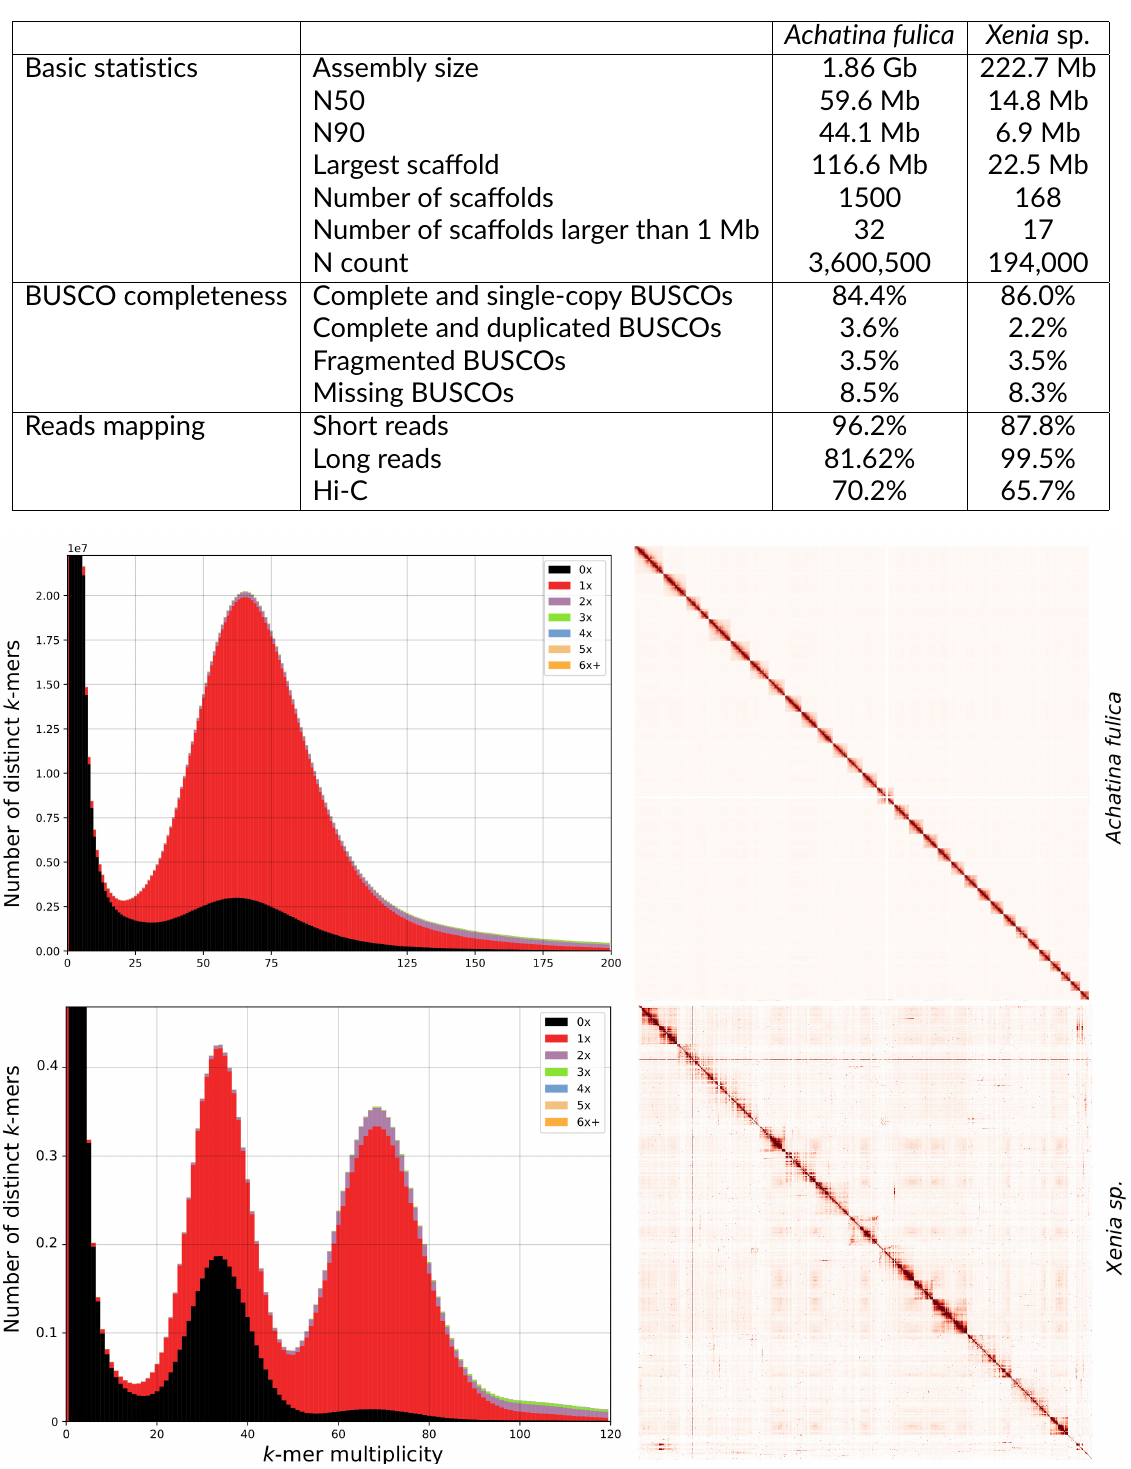
Table 3 – Assembly evaluation of Achatina fulica and Xenia sp..